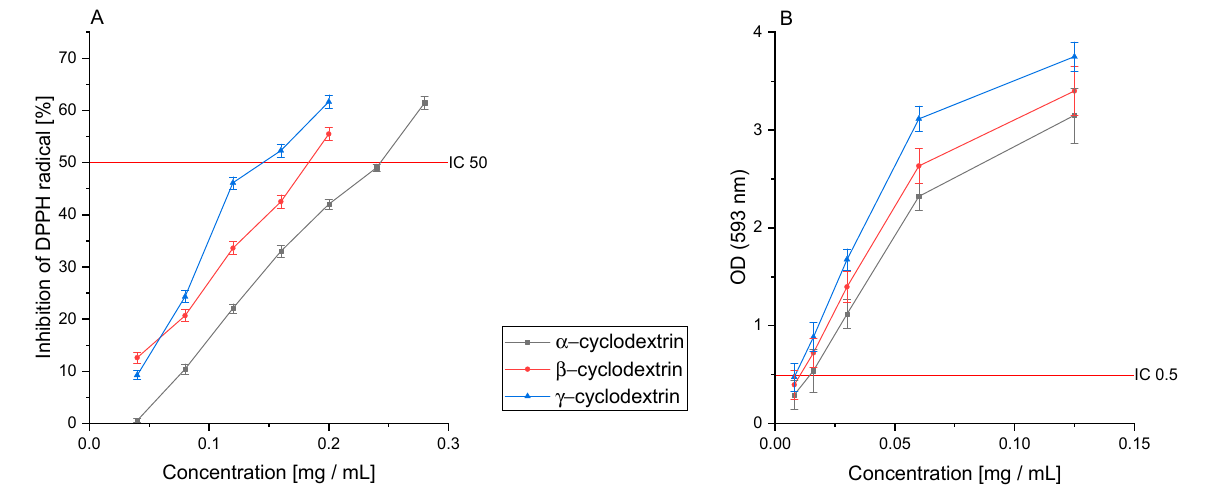
Figure 5. The antioxidant activity of the extracts obtained using selected cyclodextrins in the ( A ) DPPH and ( B ) FRAP assay. Significance at p ≤ 0.05.